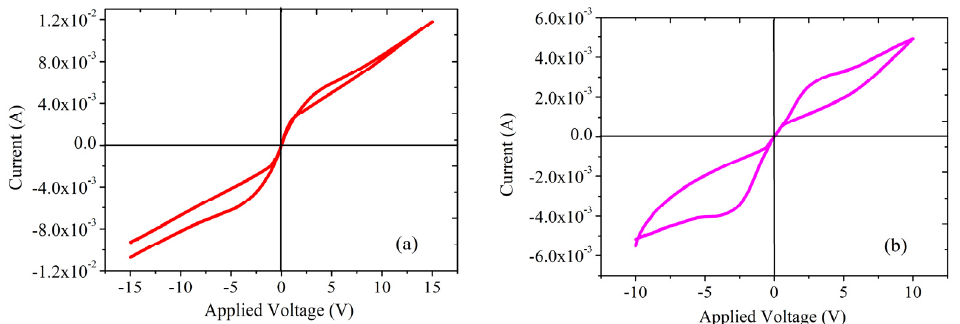
Figure 11. Forward and backward scanning I-V curves for Si/Si bonding samples prepared by O2 plasma activation time of 60 s ( a ) and 300 s ( b